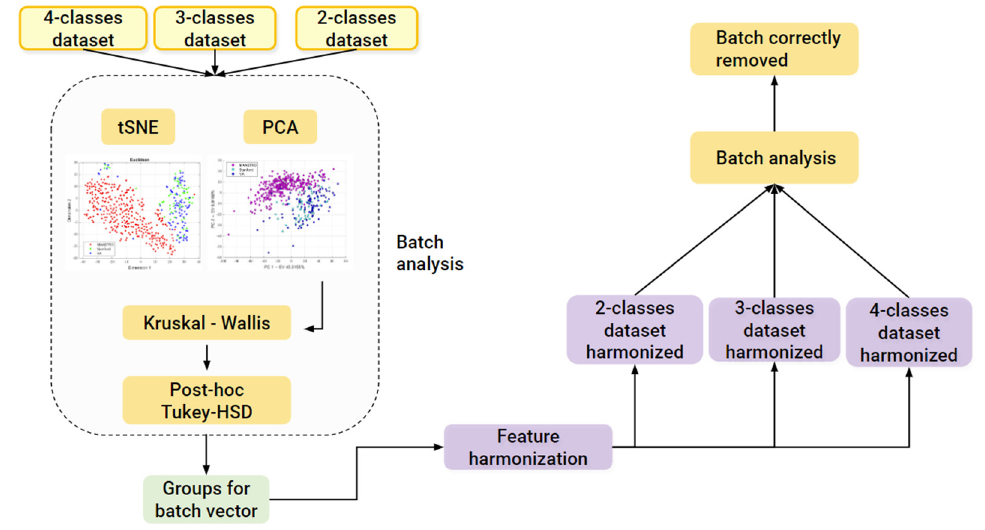
Figure 4. Batch analysis and harmonization